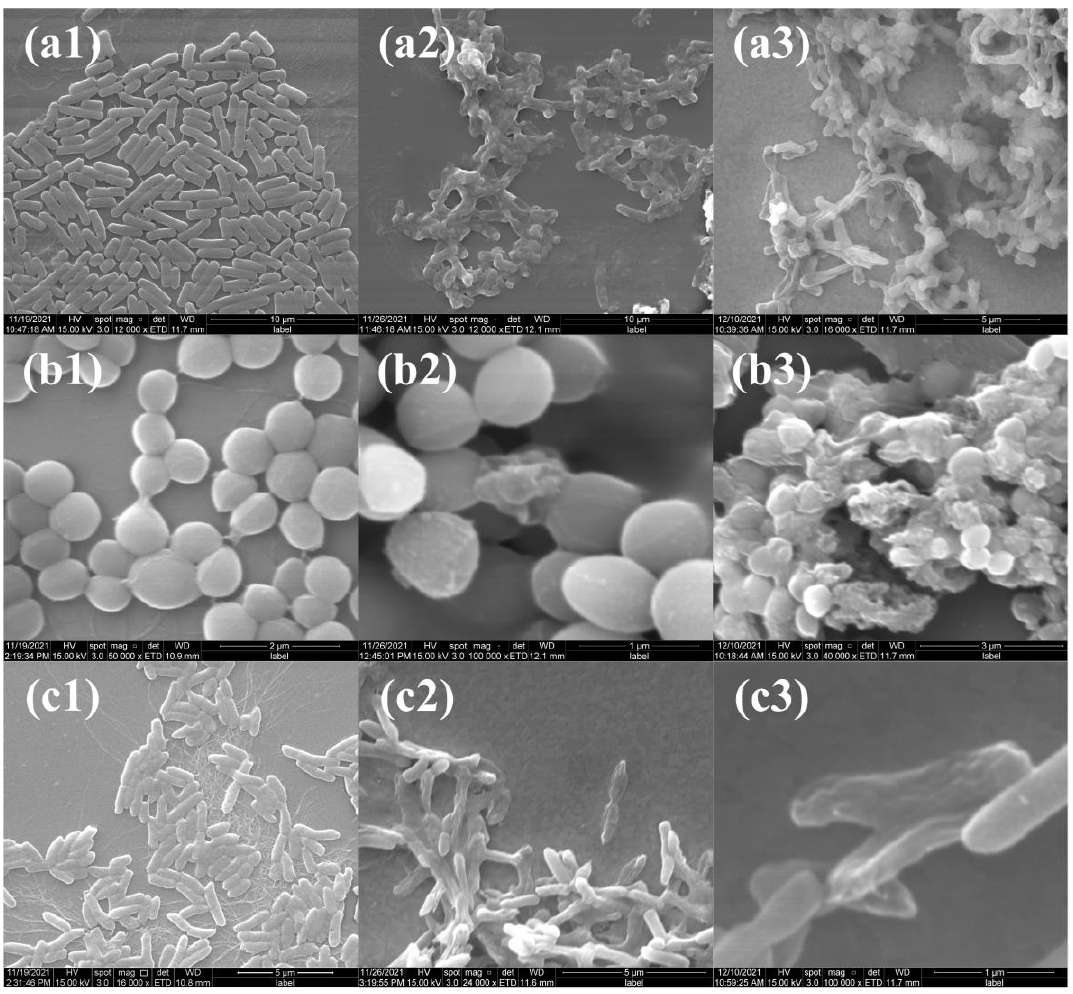
Figure 10. SEM images of E. coli ( a1 – a3 ), S. aureus ( b1 – b3 ) and P. aeruginosa ( c1 – c3 ). Control group ( a1 – c1 ), CEO groups ( a2 – c2 ), CEO−SNP groups ( a3 – c3 ). ( a1 – c1 ), CEO groups ( a2 – c2 ), CEO-SNP groups ( a3 – c3